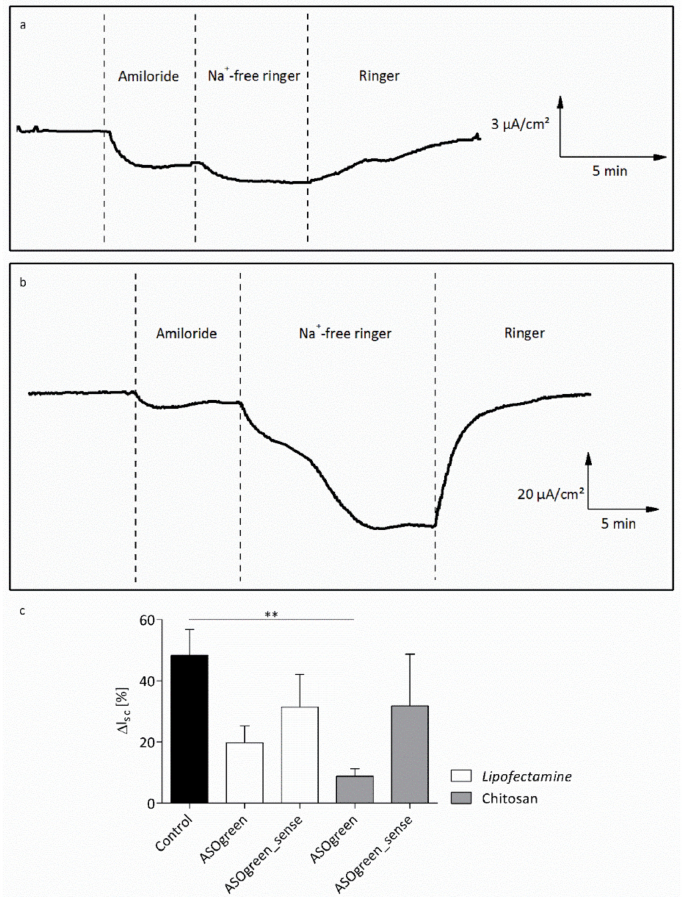
Figure 9. Transepithelial Ussing chamber measurements of NCI-H441 cells. ( a ) Representative time course of non-transfected cells, showing a slight decrease in short-circuit current (I sc ) after application of Na + -free ringer solution. ( b ) Representative time course of cells transfected with ASOgreen using CS (0.45 µ g / cm 2 ASOgreen), showing a strongly decreased I sc after withdrawal of Na + . Please note the di ff erent scales for I sc . ( c ) Statistical evaluation of amiloride-sensitive short-circuit current ( ∆ I sc ) in NCI-H441 cells after ASO transfection with Lipofectamine and CS. Cells were transfected with 0.45 µ g / cm 2 ASO, respectively; control cells were not transfected. Measurements were conducted 24 h after transfection. The amiloride-sensitive current decreased after transfection with ASOgreen. Cells transfected with ASOgreen_sense only showed a slight decrease in the amiloride-sensitive current ( p ≤ 0.01 (**); control, n = 8; ASOgreen, n = 7; ASOgreen_sense, n =